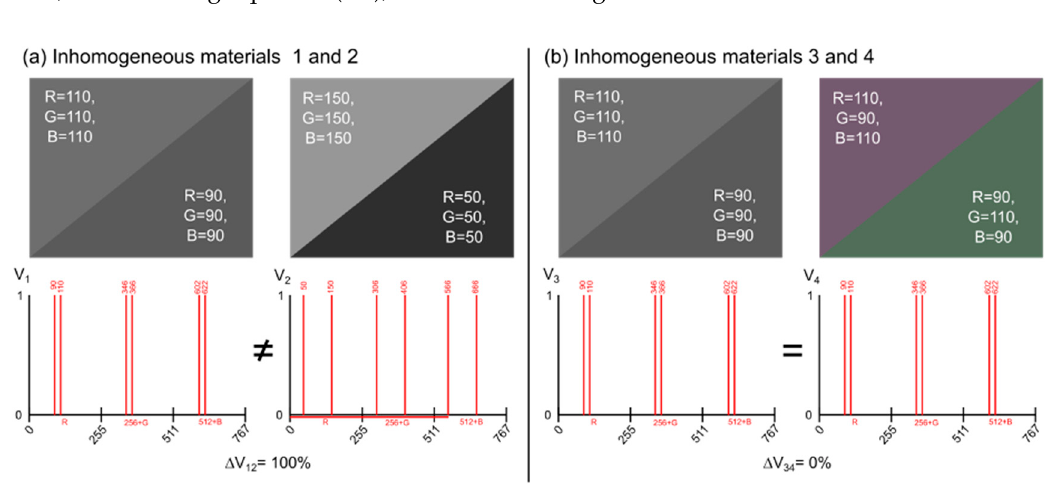
Figure A12. Schematics illustrating ( a ) homogeneous and ( b ) inhomogeneous materials and their associated vectors defined by Equation (A9). For materials as described in ( b ), the average colour vector as defined by Equation (A9) cannot be used to constitute a database, since different samples could be associated with Δ V ij = 0.